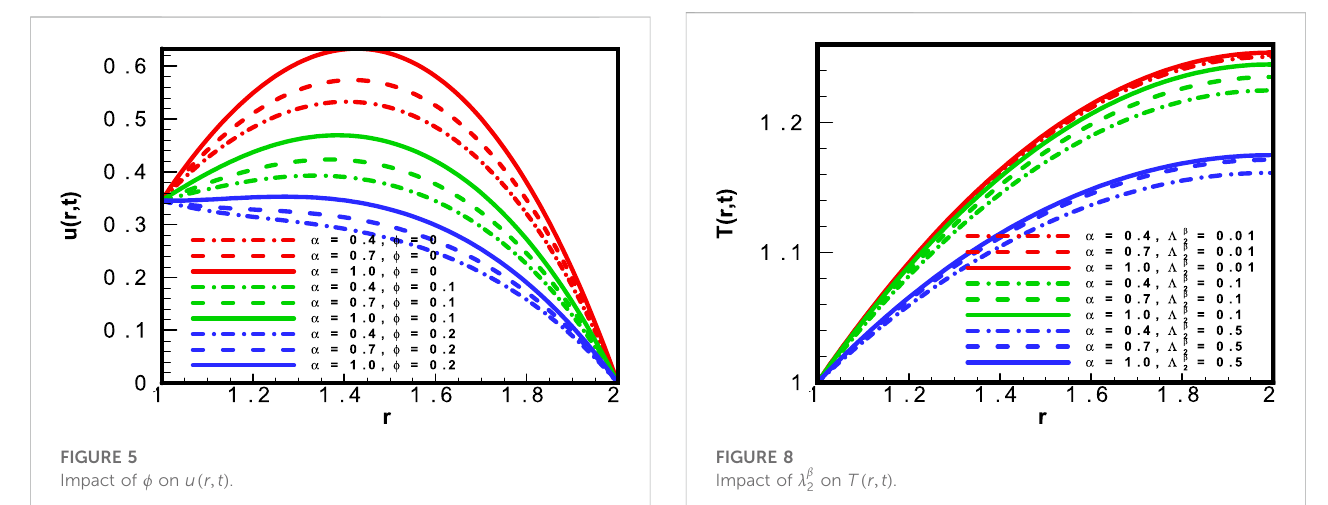
FIGURE 8 Impact of λ β 2 on T ( r , t ) .